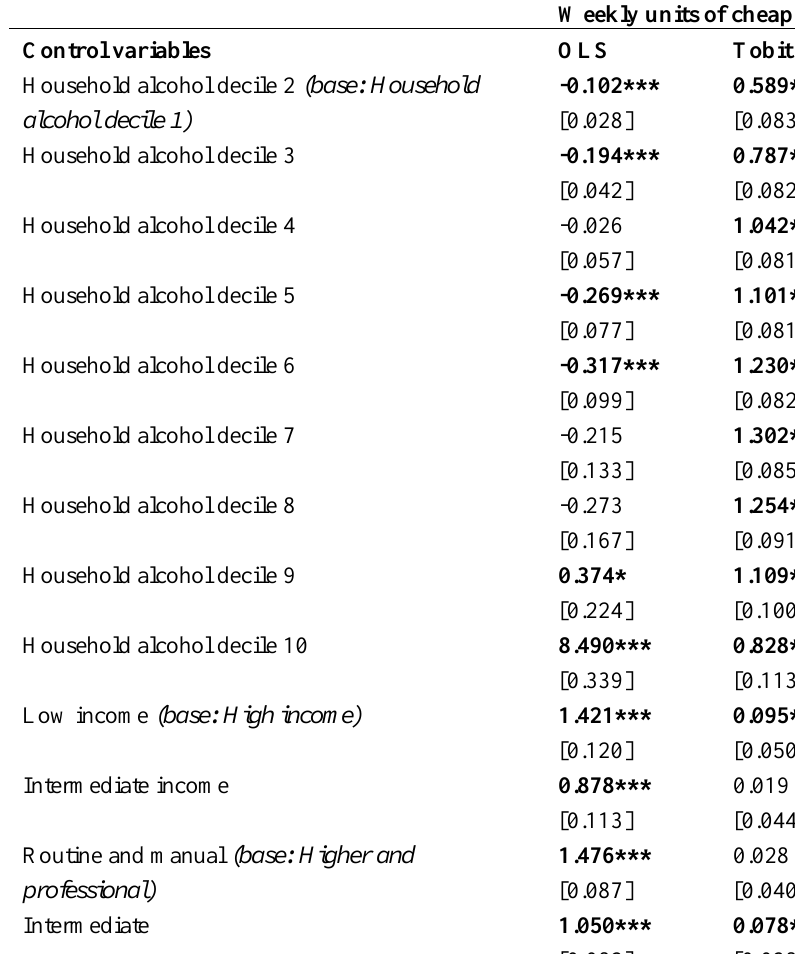
Table 3: OLS, Tobit RE and Hausman-Taylor (HT) regressions for units of cheap alcohol purchased Weekly units of cheap alcohol Control